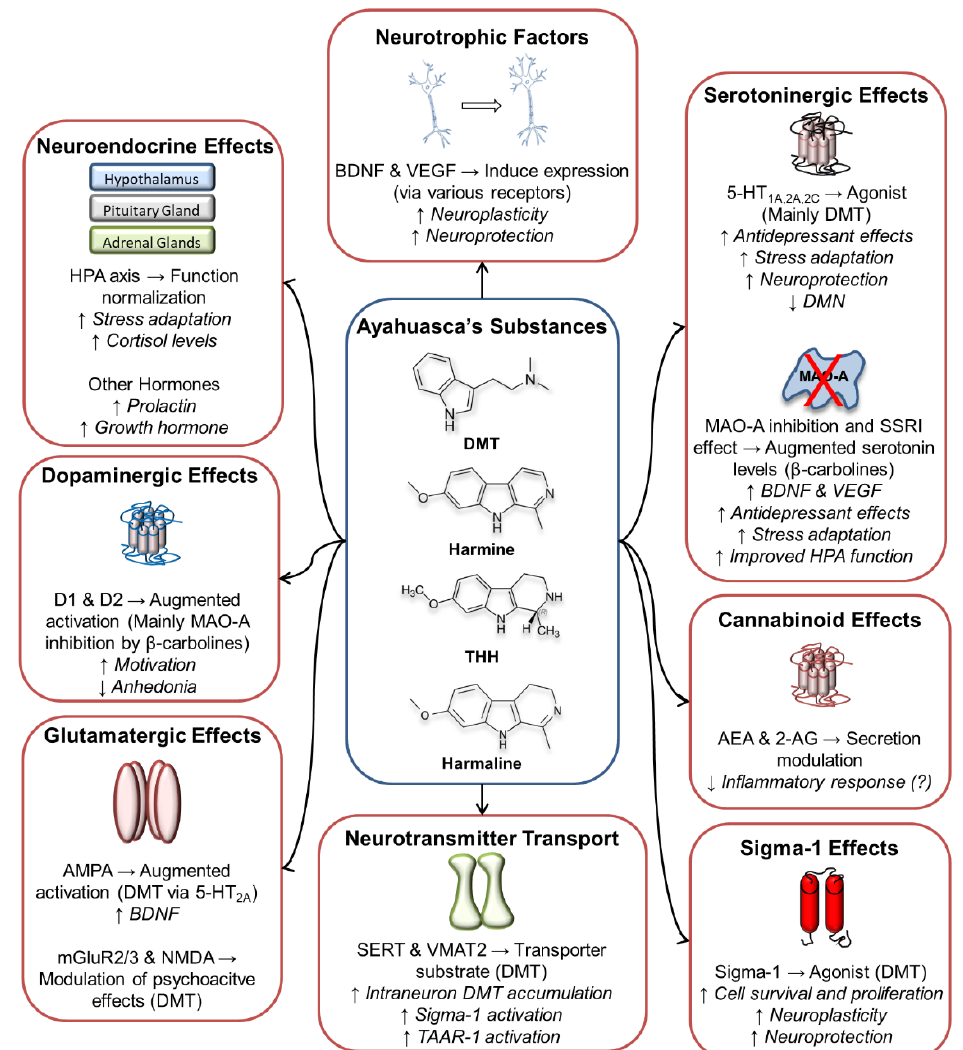
Figure 1. Main molecular targets and effects of ayahuasca’s alkaloids. 2-AG: